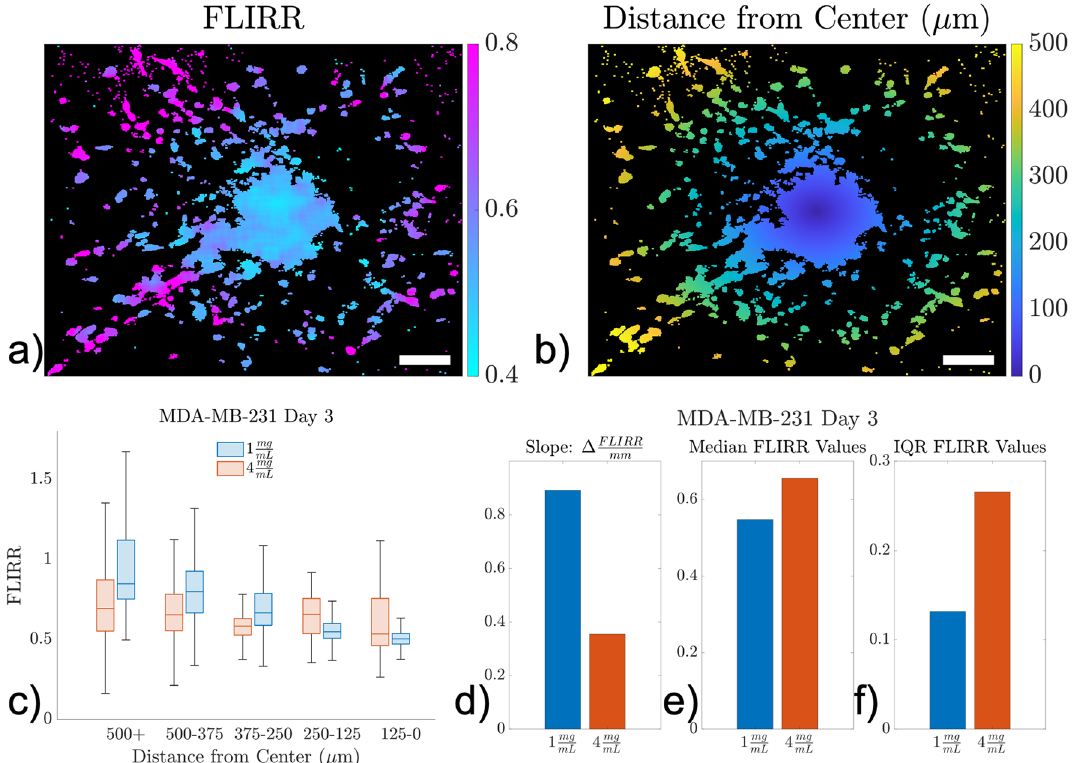
Figure 5. FLIRR gradients as distance from the centroid. ( a ) FLIRR map of an MDA-MB-231 spheroid in 1 mg/ml on Day 3. ( b ) Euclidian distance transform from the centroid of the spheroid where each pixel represents the distance away from the centroid. Scale bars (white) indicate 100 µm. ( c ) FLIRR vs Distance from the centroid plot for MDA-MB-231 at Day 3 comparing 1 mg/ml (blue) vs 4 mg/ml (red). ( d ) Linear slopes fitting the distance from center vs FLIRR values for each collagen concentration: 1 mg/ml (blue) and 4 mg/ml (red). ( e ) Medians of the FLIRR distribution of pooled samples for each collagen concentration. ( f ) Interquartile ranges (IQR) of the FLIRR distributions of pooled samples for each collagen concentration. In these samples, the cells in the 1 mg/ml samples that had migrated the farthest had a preferential shift towards larger FLIRR values consistent with a shift towards OXPHOS in the while the 4 mg/ml samples had a much more spatially heterogenous 4 mg/ml MCF-10A sample at Day 3, this trend was particularly enhanced. The cells closest to the edge of the spheroid would be directly engaging with the collagen and may represent cells in a pre-invasive phenotype 51 .